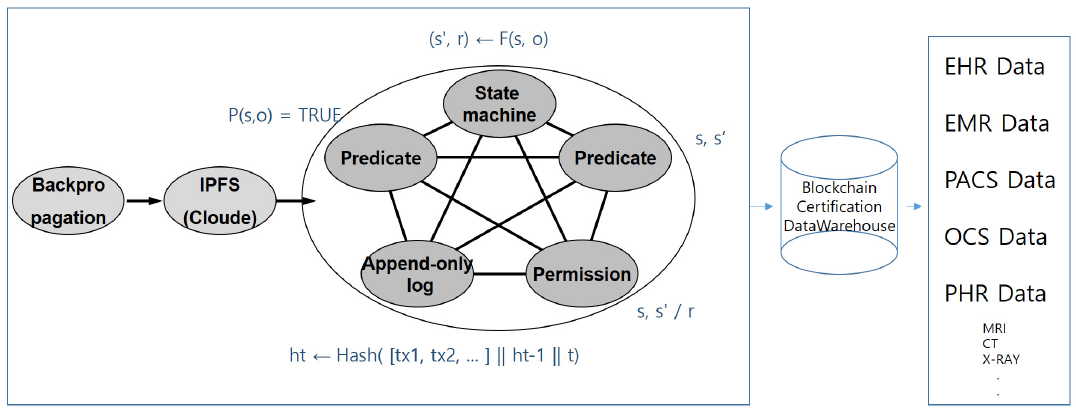
Figure 7. Error backpropagation framework for healthcare.